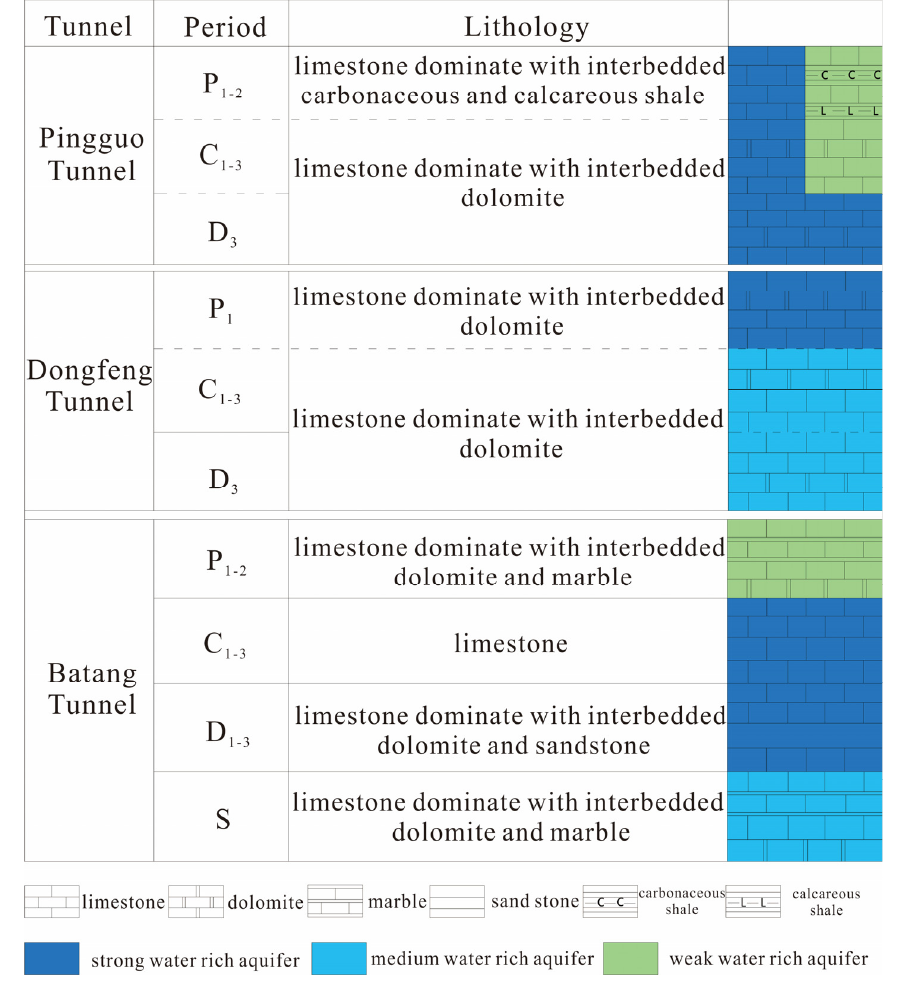
Figure 6. Lithology and water-bearing characteristics of study areas traversed by three typical railroad tunnels.